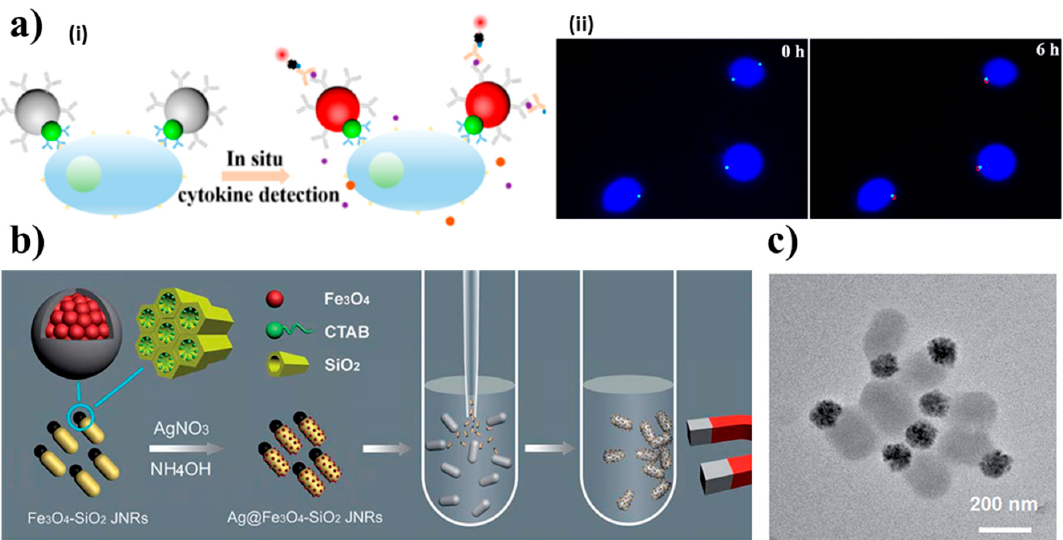
Figure 7. Scheme illustrating attachment of dumbbell particles to single cells and in situ sandwich Enzyme-Linked ImmunoSorbent Assay (ELISA) detection of cells released cytokine ( i ). Merged fluorescence images of the cell (blue) and dumbbell particles (green, small magnetic microspheres (sMS); red, big magnetic microspheres (bMS)) after ELISA detection. The images were taken at 6 h lipopolysaccharide (LPS) stimulation time. Cells were stained with CellTracker Blue CMAC (7-amino-4-chloromethylcoumarin) dye. Scale bar: 10 µm ( ii ) ( a ). Schematic illustration of a typical procedure for the in situ synthesis of AgNPs@Fe 3 O 4 -SiO 2 Janus nanorods (JNRs) and their sterilization and separation process ( b ). Magnetic Janus mesoporous silica nanoparticles Transmission Electron Microscope (TEM) images (bar = 200 nm) ( c ). Reprinted and adapted from Reference [46] ( a ), Reference [48] ( b ) and Reference [49] ( c ).